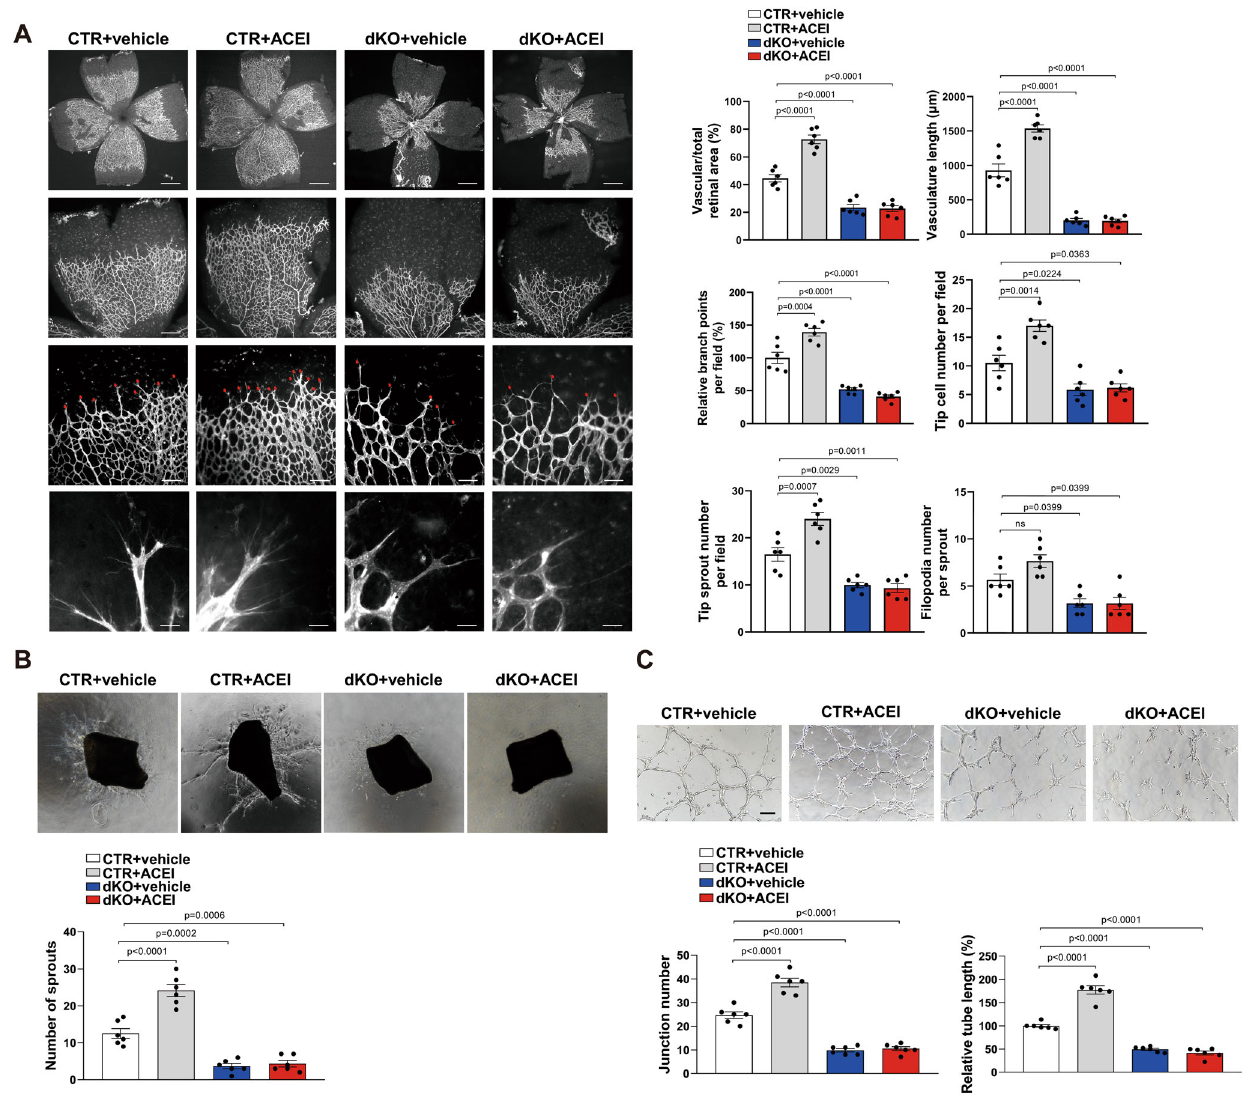
Fig.2|ACEIpromotesangiogenesisviaSp1/Sp3.A Retinalwhole-mountstaining of isolectin-B4 in P5 CTR and dKO mice treated with the vehicle or angiotensin- converting enzyme inhibitor (ACEI). n =6. Red arrowheads show tip cell sprouting and fi lopodia.Right,quanti fi cationofvascular/totalretinalarea,vasculaturelength, branch points per fi eld, tip cell number per fi eld, tip sprout number per fi eld, and fi lopodia number per sprout. Scale bars: 500 (row 1), 100 (row 2), 50 (row 3), and 10 μ m (row 4). n =6. B Aortic ring assays showing the number of aortic sprouts from CTR and dKO mice treated with vehicle or ACEI embedded in Matrigel